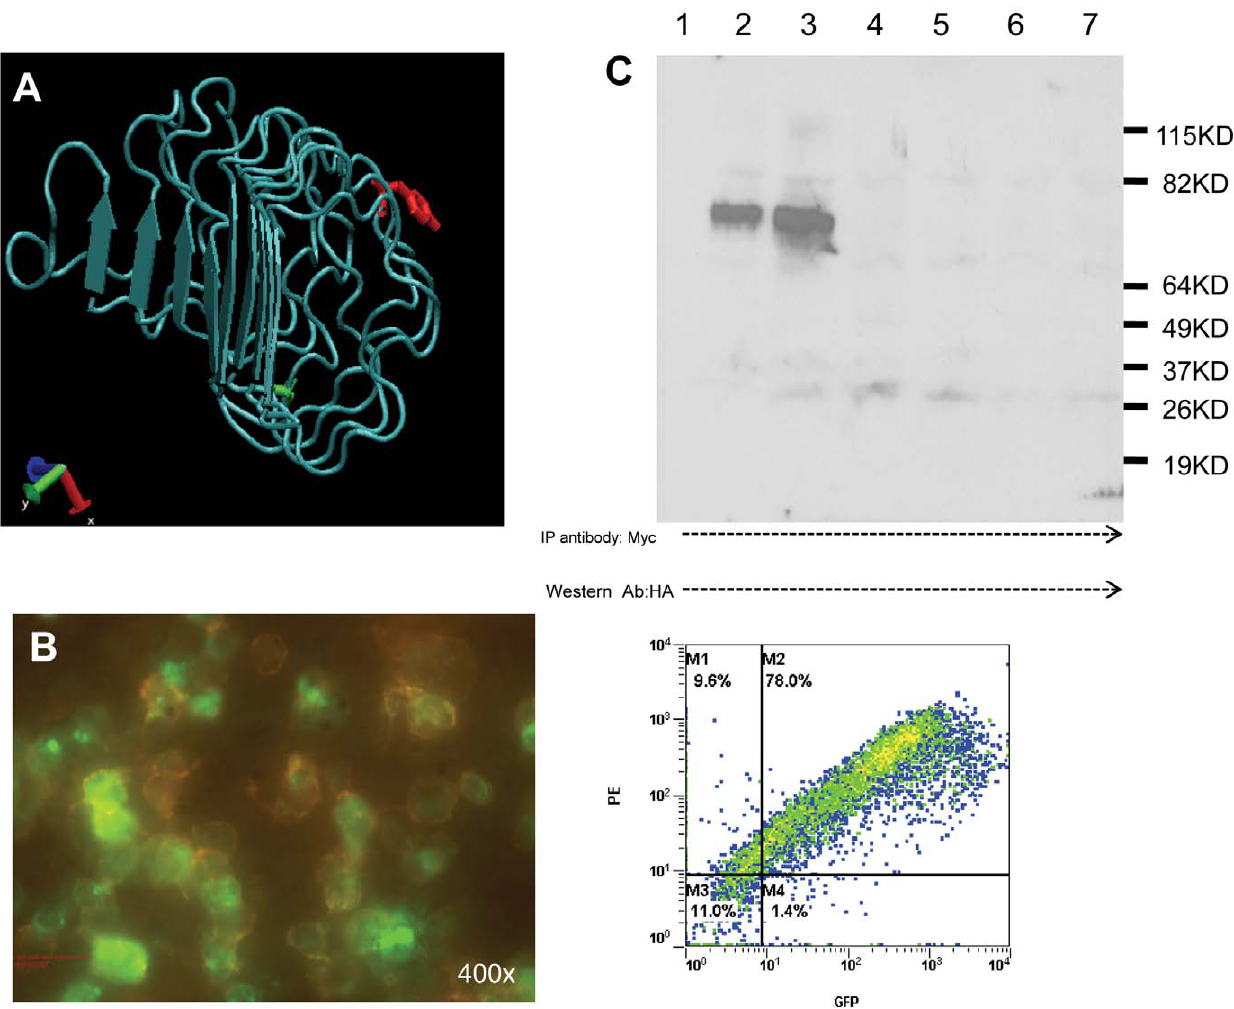
Figure 4. Co-immunoprecipitation of HA and Myc tagged TSHR ectodomain and its mutants: A ) the position of Y116 and C176 are indicated on the ECD structure. Y116 is on the outer convex surface of the LRR3 (red) and C176 (green) is on the concave inner surface of the LRR5. The coordinates for the ectodomain structure of TSH receptor was obtained from the GRIS database [43] and this structure was examined in the open source molecular graphics program VMD (www.ks.uiuc.edu/Research/vmd) to mark the position of Y116 and C176 on the ECD structure. B ) Expression of the Y116 on HEK 293 cells is indicated both microscopically and quantitatively by flow cytometry. The yellow staining observed on the cell surface was due to double staining of GFP (on the C-terminus of construct) and TSHR antibody (RSR1 or M1 residue 381–385) labeled with secondary antibody conjugated to texas red. The FACS profiles on right shows that 78% of these cells to be double positive. The C176 construct expressed on HEK 293 had similar levels of expression (data not shown). C ) as described above, constructs carrying the Y116 or C176 mutations (in the HA-GPI-TSHR-ecd) were co-transfected with Myc-GPI-TSHR-ecd. Membranes prepared from single and double transfected cells were immunoprecipitated using anti-Myc monoclonal antibody 9E10 (2 m g/ml final). The PVDF transferred immune complex was probed with anti-HA (1 m g/ml) and developed further with secondary antibody conjugated to HRP. Lane 1 ) Membranes from single transfected cells ( HA-GPI-TSHR-ecd only ) and subjected to identical co-immunoprecipitation conditions. Lane 2 ) Membranes from double transfected cells ( HA-GPI-TSHR-ecd + Myc-GPI- TSHR-ecd ). Lane3 ) Membranes from double transfected cells ( C176 D HA-GPI-TSHR-ecd + Myc GP-TSHR-ecd ). Lane 4 ) Membranes from double transfected cells ( Y116 D HA-GPI-TSHR-ecd + Myc-GPI-TSHR-ecd ). Lane 5 ) Membranes from single transfected cells ( C176 D HA-GPI-TSHR-ECD only ). Lane 6 ) Membranes from single transfected cells ( Y116 mutant HA-GPI-TSHR-ecd only ) and Lane 7 ) Membranes from untransfected HEK293 cells. Only monomeric forms are seen with immunoprecipitation and reduction in lanes 2 and 3. Mutation of Y116 caused loss of receptor interaction and higher order forms and thus no immunoprecipitation of TSHR-ecd (lane 4). doi:10.1371/journal.pone.0009449.g004 observe FRET with an efficiency of 8–10% in HA-GPI-TSHR-ecd Y116 Mutation on Wild Type TSHR Leads to Receptor + Myc-GPITSHR-ecd transfected cells which was lower than the Degradation control cells with full-length receptors tagged at their carboxyl end To study if the Y116 mutation had any effect on receptor with GFP as donor and Myc antibody labeled with Cy3 as an degradation in the context of the transmembrane region, we acceptor (FRET efficiency of 20–25%, Figure 5). There was no mutated Y116 to serine on the full length TSHR GFP . FRET FRET in single transfected cells. The FRET data on these N- efficiency between the Y116 mutated TSHR GFP construct and the terminus tagged GPI-TSHR-ecd cells further confirmed the interaction of ectodomains observed with immunoprecipitation. Myc labelled non-mutated TSHR myc tagged full-length (WT)